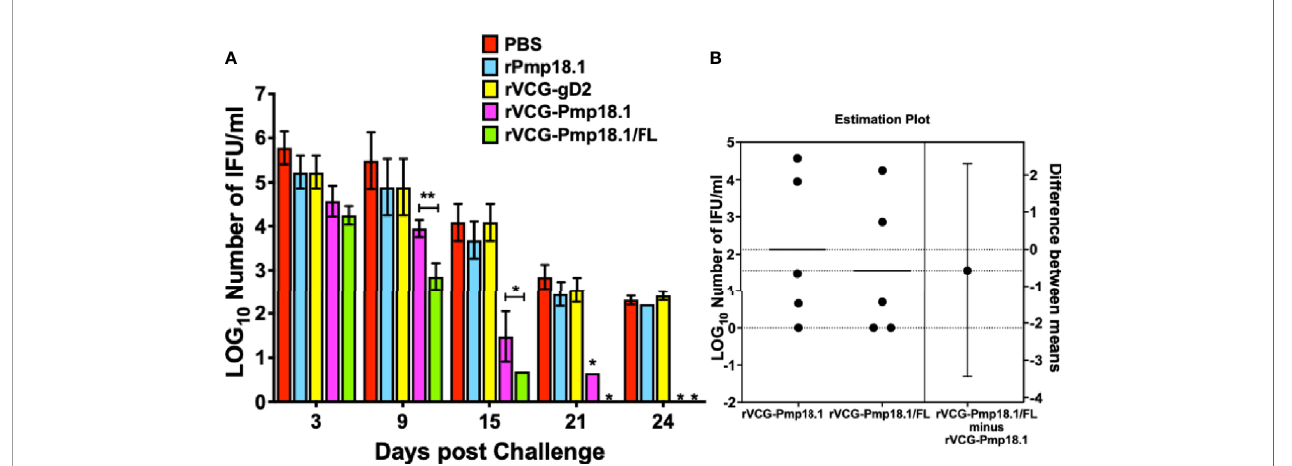
FIGURE 4 | Cross protection against heterologous intravaginal challenge with C. abortus B577. Groups of mice immunized IN were challenged intravaginally with 1 x 10 6 IFU of live heterologous C. abortus B577 4 weeks after the last immunization. Infections were monitored by cervicovaginal swabbing of individual animals at the indicated time points after infection and C. abortus was isolated from swabs in tissue culture and enumerated. The data show (A) the mean recoverable IFUs expressed as log 10 IFU/ml ± S.D. and (B) the mean difference between rVCG-Pmp18.1 and rVCG-Pmp18.1/FL in an unpaired t test estimation plot. Group means at the different time points are plotted on the left axes; the mean difference is plotted on the right Y axis. The adjuvant effect size, the mean difference between means ± SEM (-0.5700 ± 1.244) is depicted as a bar. Precision of the calculated effect size as a 95% con fi dence interval (right axis) is indicated by the ends of the vertical error bar. Differences in the mean recoverable IFUs between rVCG-Pmp18.1 and rVCG-Pmp18.1/FL were compared by paired Student ’ s t test at p * < 0.05 and p **